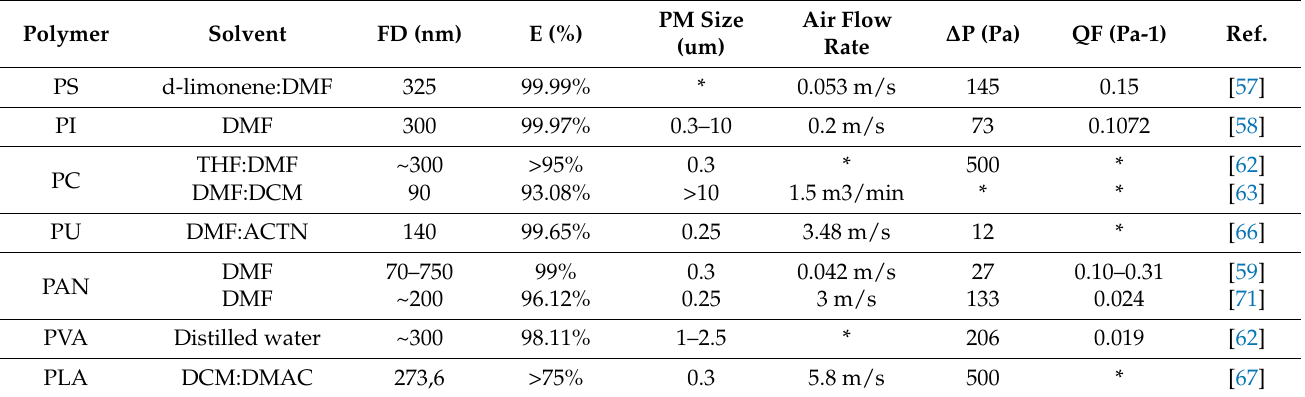
Table 1. Comparison of polymeric nanofibers used for the development of electrospinning-derived air-filtering systems reported in the literature. FD—fiber’s diameter; PM—particulate matter; ∆ P— pressure variation; QF—quality